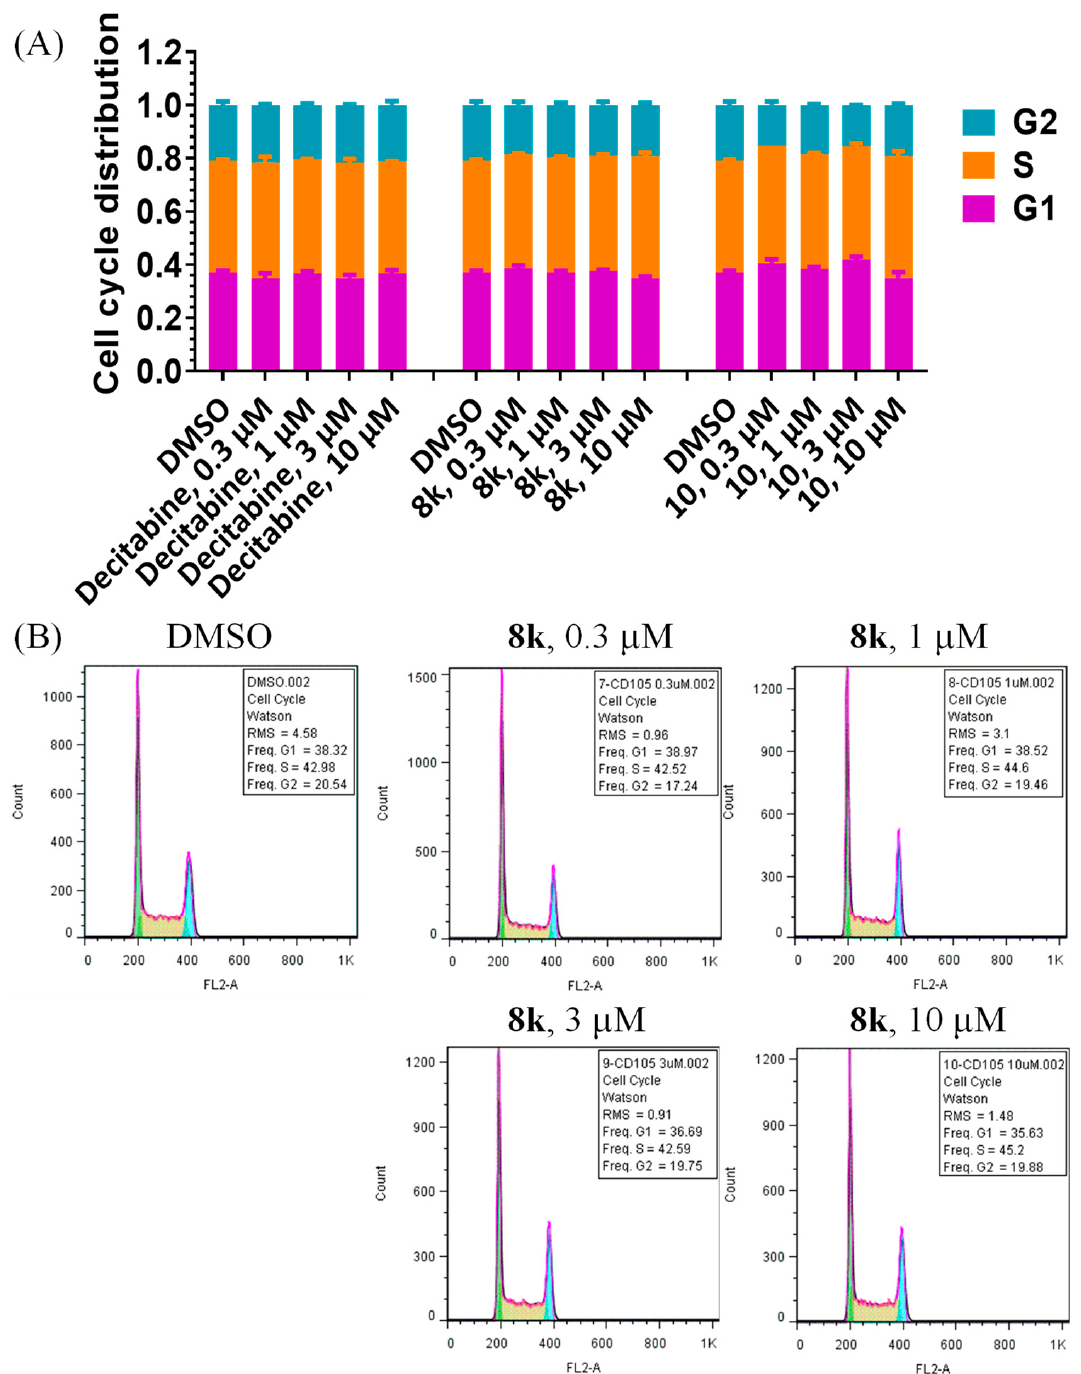
Figure 5. Cytometric flow analysis of cell cycle distribution of MV4-11 cells in the presence of 8k (CD105), 10 (CE045), and Decitabine at the indicated concentrations for 48 h. ( A ). Normalized cell cycle distribution, ( B ) Cell cycle distribution figures of 8k , while those of 10 and Decitabine can be found in SI Figures S1 and S2. The experiments were repeated twice.